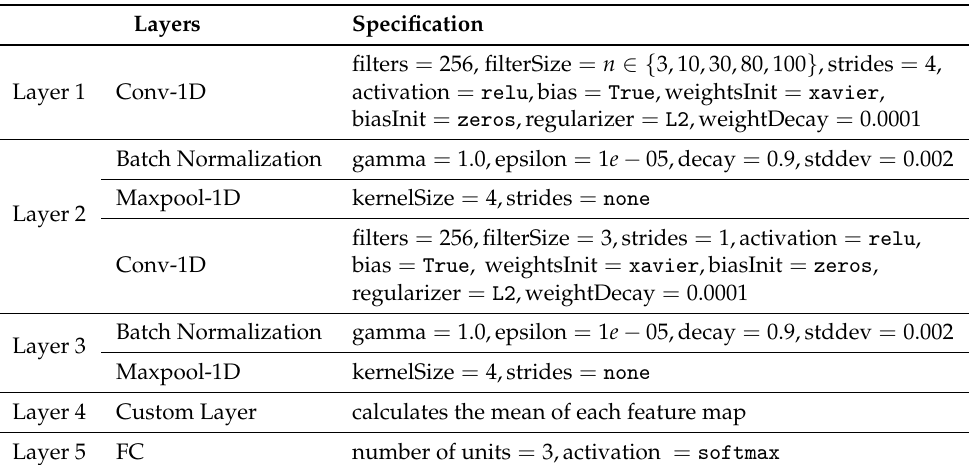
Table 2. RawConvNet’s layer specification.